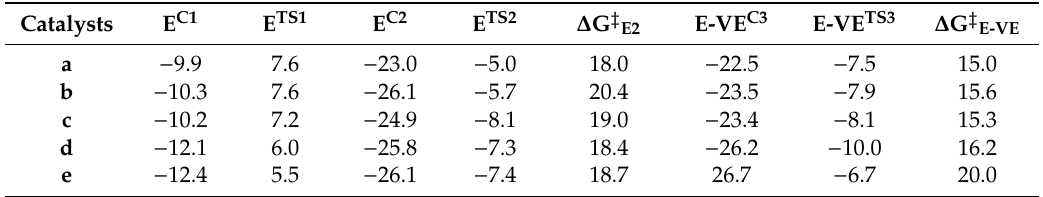
Computed energies for ethylene polymerization and ethylene (E) vinyl ether (VE) copolymerization catalyzed by alkyl-BPMO-palladium ( a , b , c , d and e ) catalysts. E C1 , E C2 , E TS1 , and E TS2 are first and second ethylene coordination complexes and transition states, respectively. E-VE C1 and E-VE TS1 are coordination complexes and transition states of ethylene and vinyl ether copolymers,